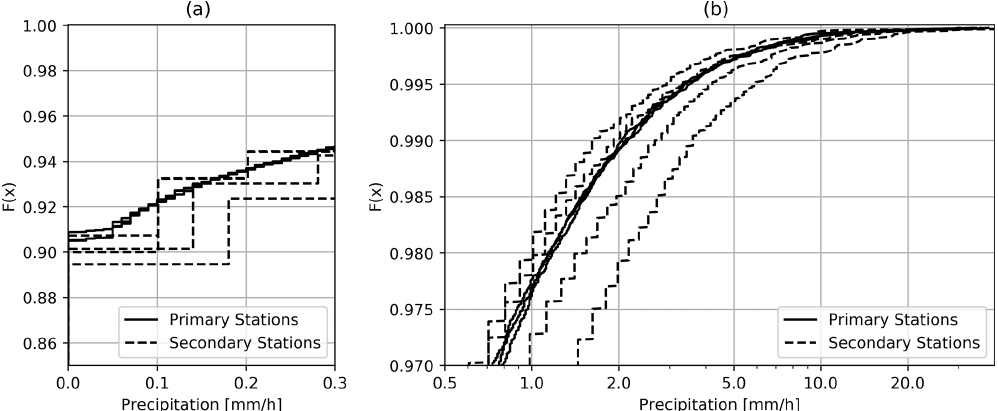
Figure 5. Probability of no precipitation (a) and the upper part of the empirical distribution functions (b) for three primary stations (solid lines) and four secondary stations (dashed lines) from a small area in the city of Reutlingen, based on a sample size of 15990 data pairs (hourly precipitation). The distance between the primary stations is between 5.5 and 9km, and the distances from the secondary stations to the next primary stations range from 1 to 3km.